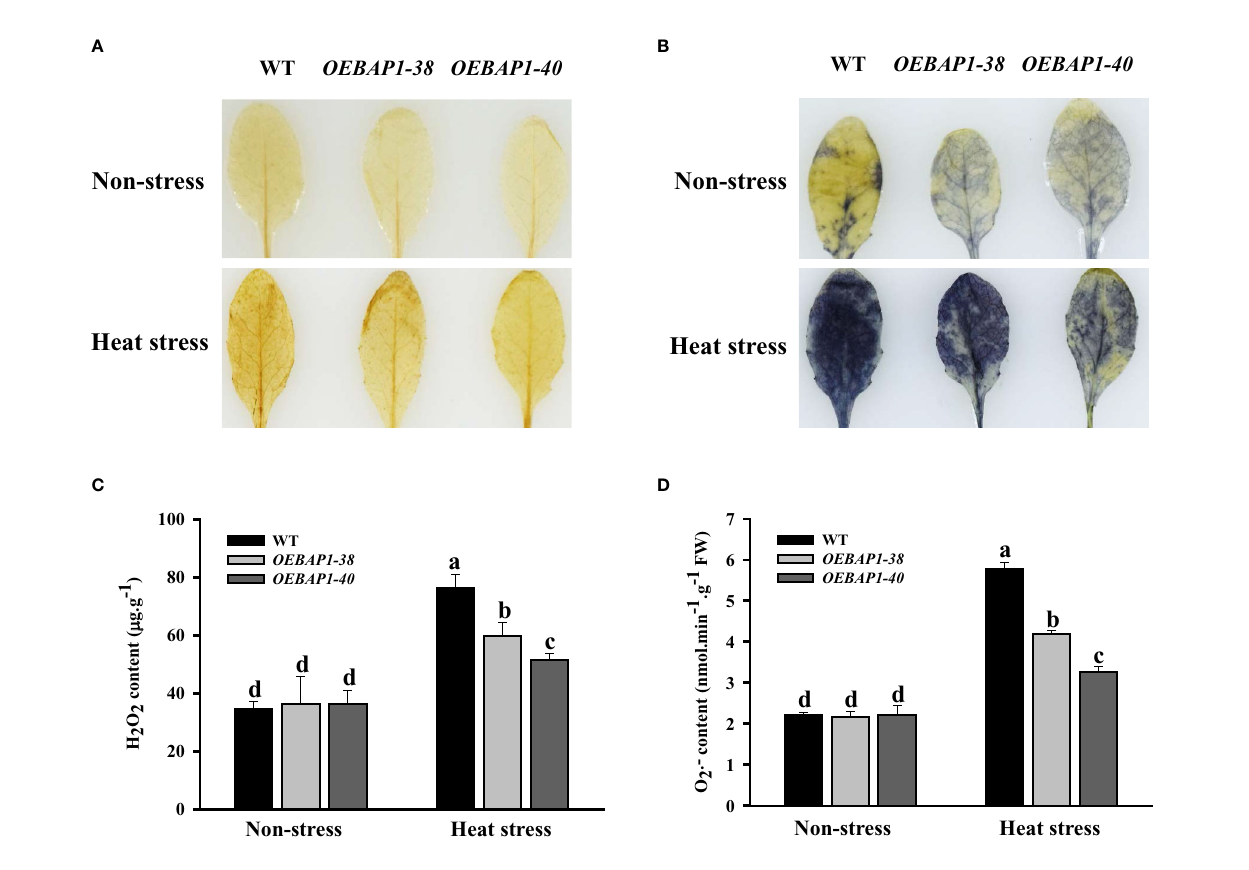
FIGURE 4 | Changes in the levels of accumulated ROS in VvBAP1 -overexpressing Arabidopsis leaves under heat stress. In situ accumulation of H 2 O 2 (A) and (O − 2 ) (B) in leaves treated with and without heat stress (45°C for 2 h) revealed by DAB and NBT staining, respectively. Quantitative measurement of H 2 O 2 (C) and (O − 2 ) (D) concentrations in leaves treated with and without high temperature with and without heat stress (45°C for 2 h). Each experiment was conducted thrice. Values are the means ± SE of three independent experiments ( P < 0.05). Lower-case letters above bars denote signi fi cant differences attested by Tukey ’ s HSD